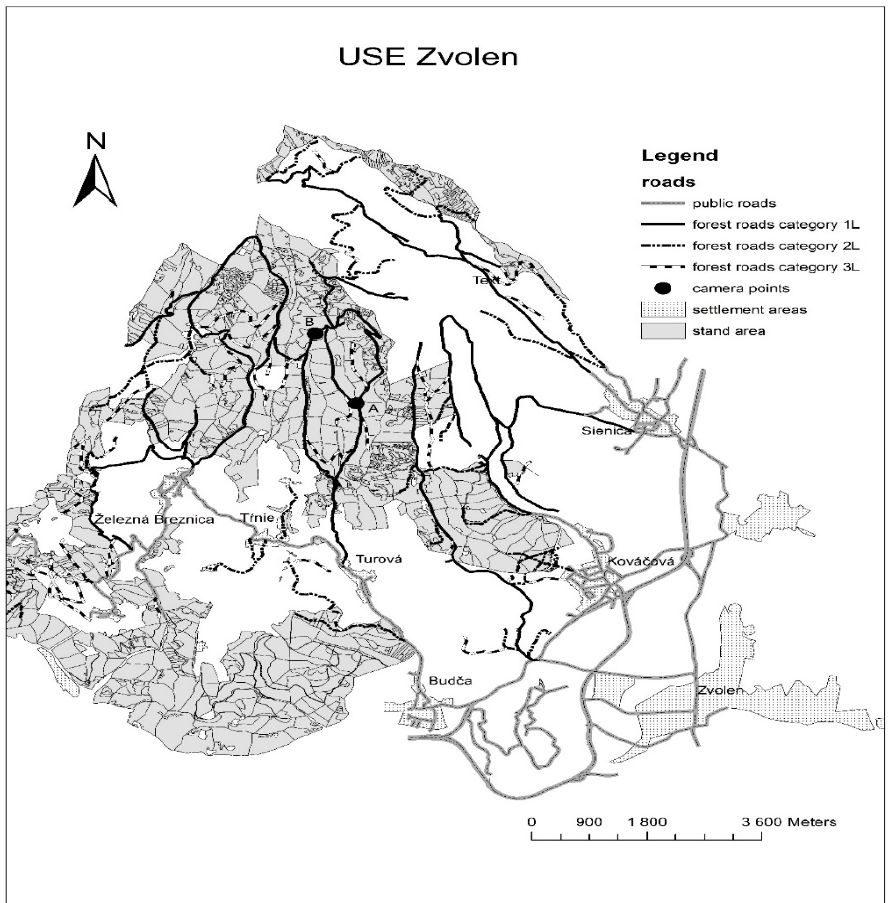
Figure 1. Study area of University Forest Enterprise Zvolen. (Note: Forest road category 1L: transport roads enabling year-round operation thanks to their spatial arrangement and technical components. Roads have the surface layer made of various construction materials and drainage facilities. The minimum width of a lane is 3.0 m, the free road width is at least 4.0 m. The maximum longitudinal slope of the road crown is 10% (in extreme cases 12%). Forest road category 2L: transport roads enabling at least seasonal operation (favourable climatic conditions) based on their spatial arrange- ment and technical components. Depending on the bearing capacity of the underlying soils, it is recommended to use the road surface with operational reinforcement or to use a simple dusty surface and drainage facilities. The minimum width of a lane is 3.0 m, the free width of the road is at least 4.0 m. The maximum longitudinal slope of the road crown should not exceed 12%. Forest road category 3L: skidding roads used for skidding and extraction of timber, usable by skidders, special skidding and extraction machines. Under favourable conditions, timber transport is possible. Road surface can have operational reinforcement, partial operational reinforcement, or no reinforcement. The minimum free road width is 4.0